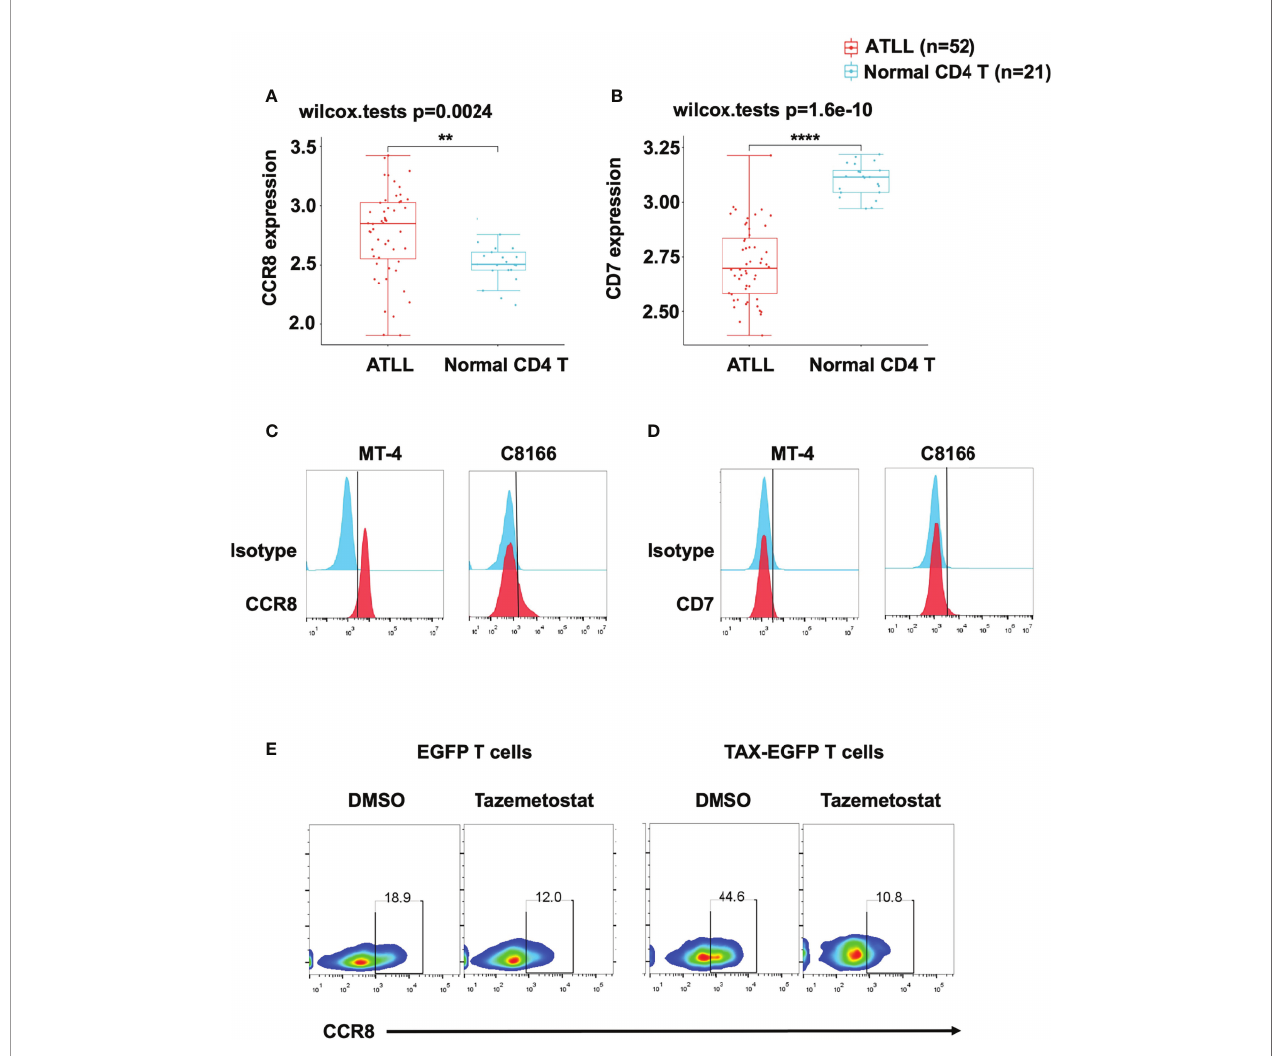
FIGURE 1 | CCR8 was highly expressed in ATLL patients and cell lines. (A, B) The expression distribution of CCR8 (A) and CD7 (B) gene in in ATLL patients ( N = 52) and normal CD4 T cells ( N = 21) from healthy donors were analyzed in the publicly datasets (www.aclbi.com) (19) and the data were obtained from GEO database (GSE33615), where the horizontal axis represents different groups of samples, the vertical axis represents the gene expression distribution, where different colors represent different groups, and the upper left corner represents the signi fi cance p-value test method (wilcox.tests); (C, D) The levels of CCR8 (C) and CD7 (D) , as detected by fl ow cytometry, in MT-4 and C8166 cells; (E) The level of CCR8 was determined by fl ow cytometry in TAX-expressing and EGFP T cells (Day 9) upon treatment with DMSO or the EZH2 inhibitor tazemetostat (1 m M, MCE) for 24 h. **P < 0.01, ****P ≤